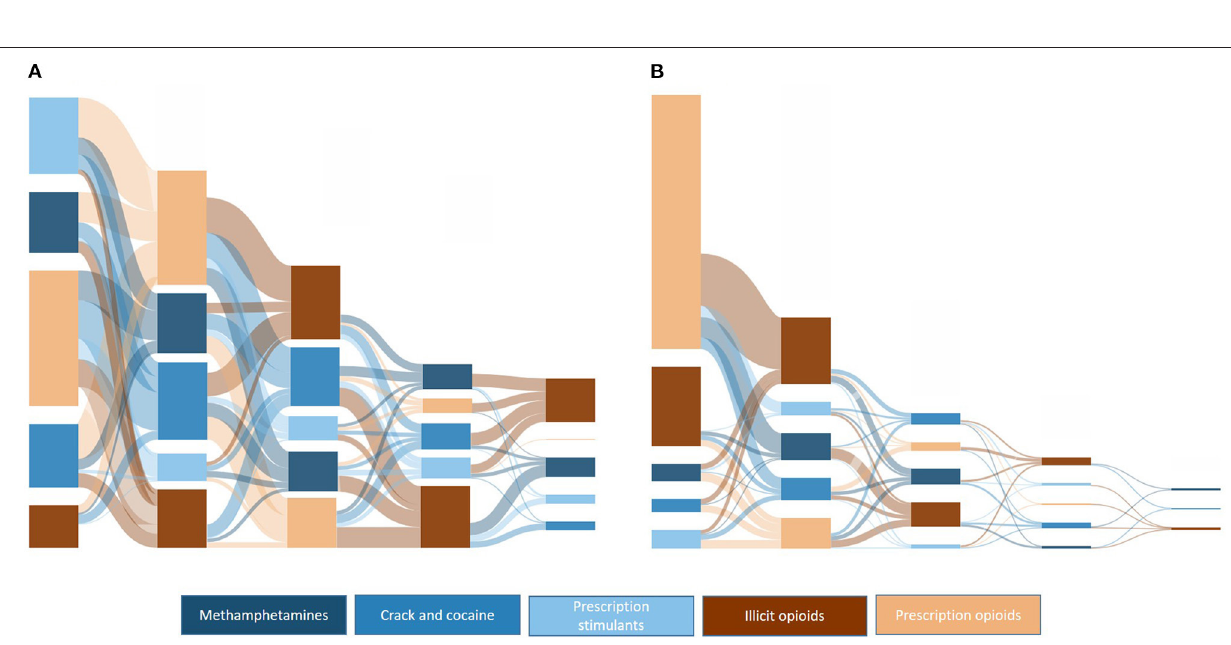
Frontiers in Psychiatry |